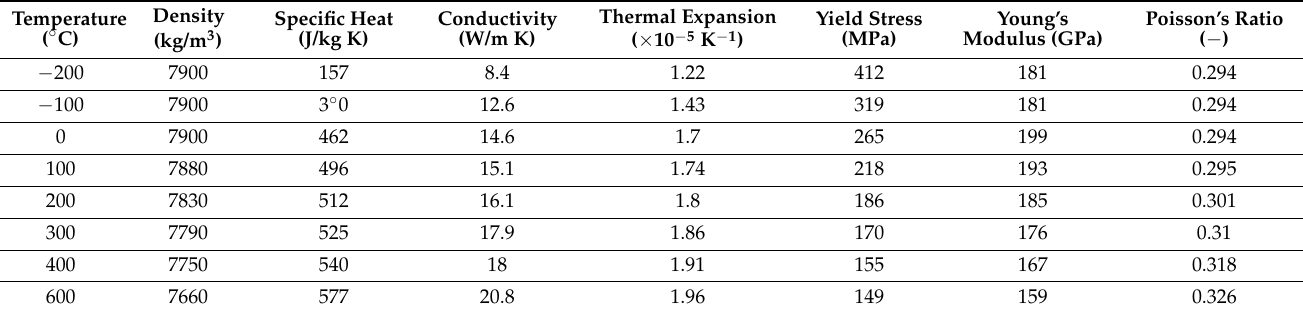
Table 2. Thermo-mechanical properties of 304L